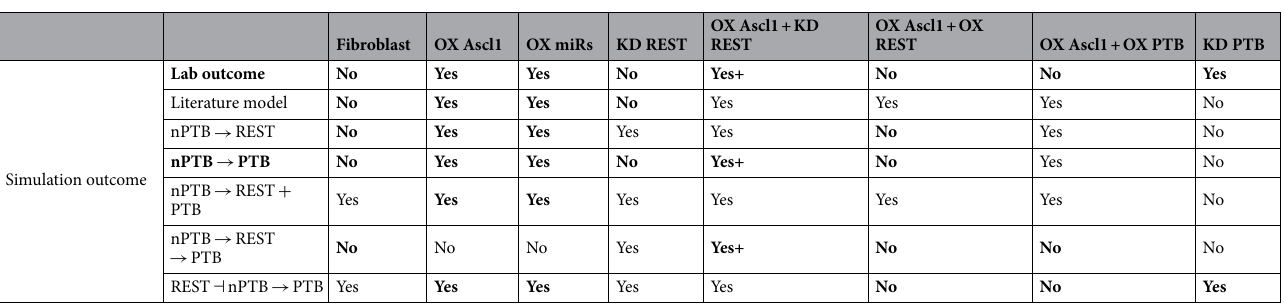
Table 2. The nPTB → PTB model correctly predicts conversion outcome of most overexpression and knockdown scenarios. Conversion outcome is shown for several OX and KD experiments described in literature (discussed in Table 1), and compared to outcome predicted by quantitative models. Simulated outcome was considered to predict conversion (“Yes”) if Ascl1 expression exceeded 1 at any time point during at least 1 out of 50 simulations, and no conversion (“No”) otherwise. In the case of OX Ascl1 + KD REST, all models predict conversion because it is an explicit feature of the training data. For this reason, a higher conversion efficiency was required (indicated by a plus sign) in this experiment as compared to OX Ascl1. Bold cells indicate outcomes that correspond to lab experiments. Full simulation results are shown in Supplementary Fig.